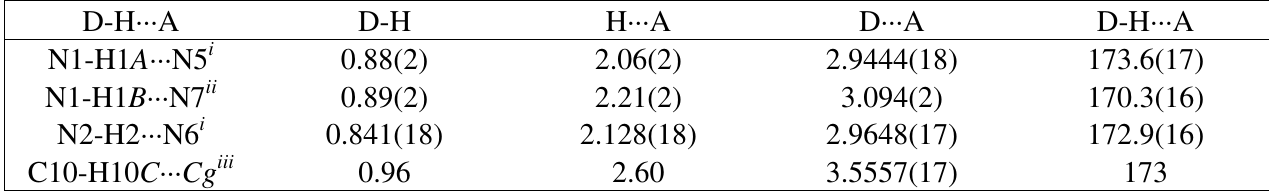
Table 3. Geometry of hydrogen bonds and CH··· π interactions in the crystal (Å,